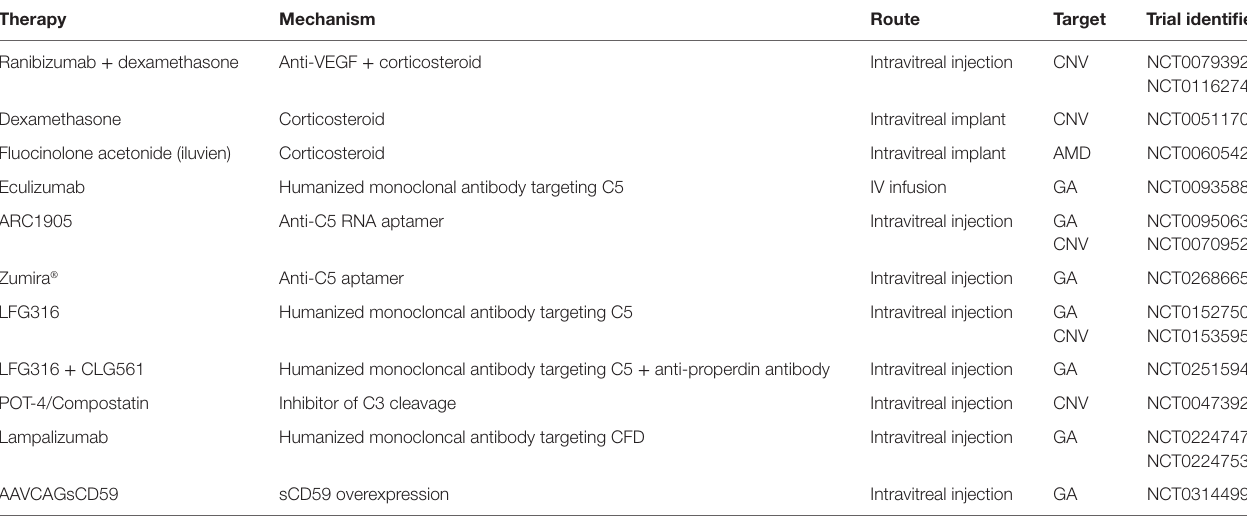
TABLe 1 | Completed and ongoing clinical trials to reduce inflammation and complement activation in age-related macular degeneration (AMD).